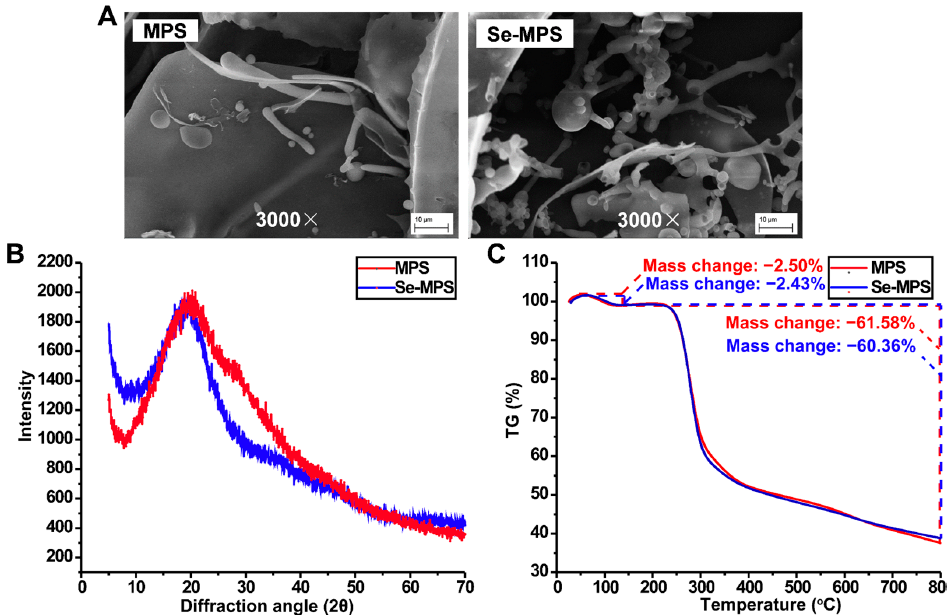
Figure 5. SEM ( A ), XRD ( B ), and TG ( C ) analysis of MPS and